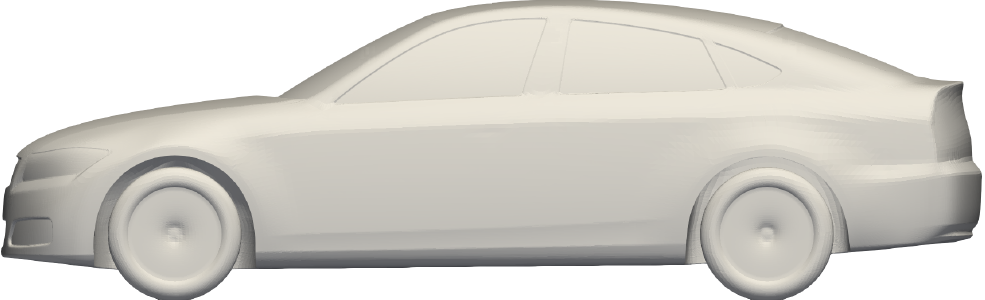
Figure 3. DrivAer car model adopted for the simulations presented in this